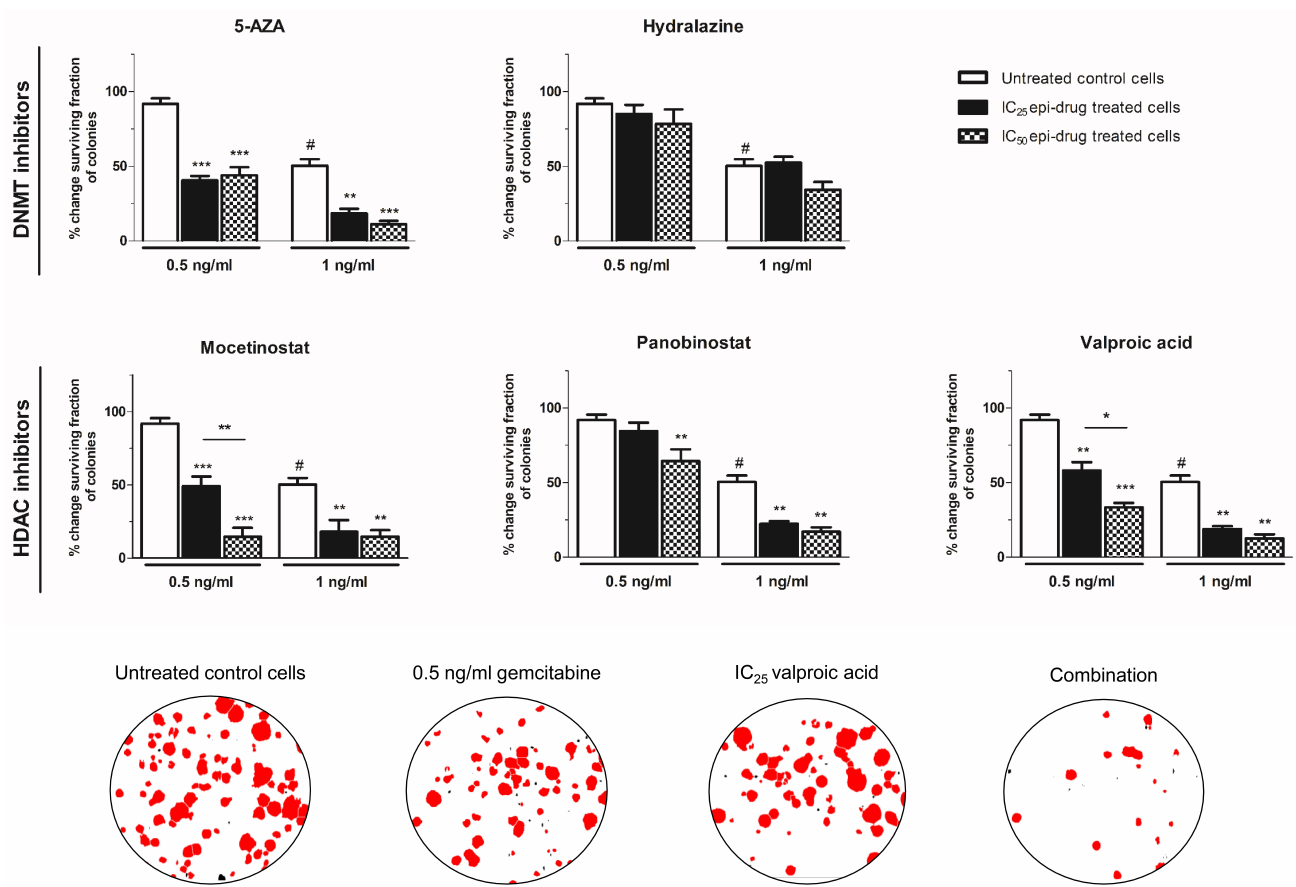
Figure 3. Cytotoxic effect of gemcitabine, with or without epi-drugs, on colony formation. Column bars represent the effect of seven days gemcitabine (0.5 and 1 ng/mL) in untreated control cells (white bar), IC 25 epi-drug treated cells (black bar), and IC 50 epi-drug treated cells (black dotted bar) on surviving fraction. Data are presented as a percentage of the vehicle-treated control. For epi-drug treated cells, the effect of the epi-drug alone was set on 100% and used as control. Photomicrographs of treatment effects on KPC3 colonies. Red stained colonies represent the measured colonies. Based on cut-off values for number and size, black stained colonies were excluded. Values represent mean ± SEM of at least two independent experiments and are shown as a percentage of control. * p < 0.05, ** p < 0.01, and *** p < 0.001 versus control. # p < 0.01 versus untreated control